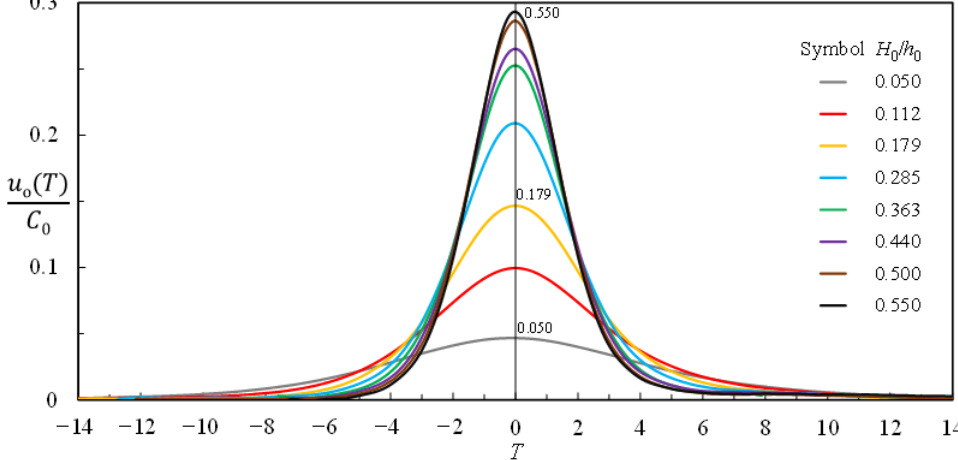
Figure 12. A comparison of temporal variations in the dimensionless free-stream velocity for H 0 / h 0 = 0.050–0.550.